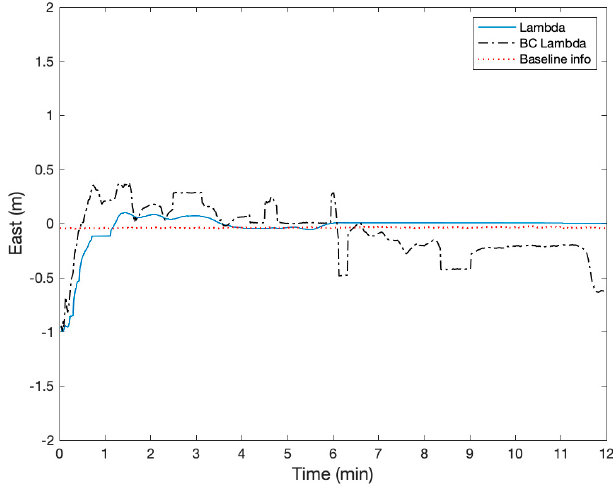
Figure 13. Comparison of the relative positioning error in the East using Least-squares Ambiguity Decorrelation Adjustment (LAMBDA), Baseline Constrained (BC) LAMBDA, and the proposed method using baseline information.